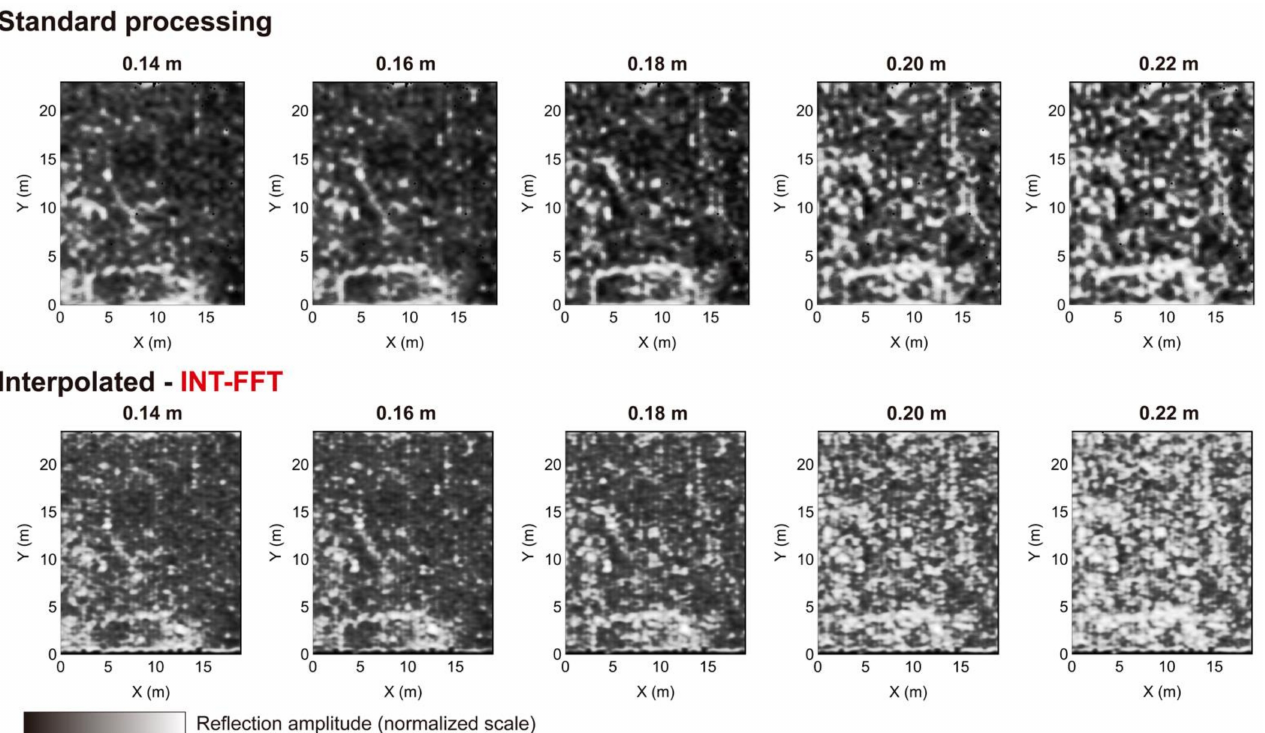
Figure 12. Depth slices of the 2015 GPR dataset with standard processing. The better processing of these data does not eliminate the reflections around the alignments that correspond to wall-like structures. Data interpolation with the INT-FFT methodology improves the sharpness of alignments corresponding to structures. However, it also increases the reflections corresponding to background